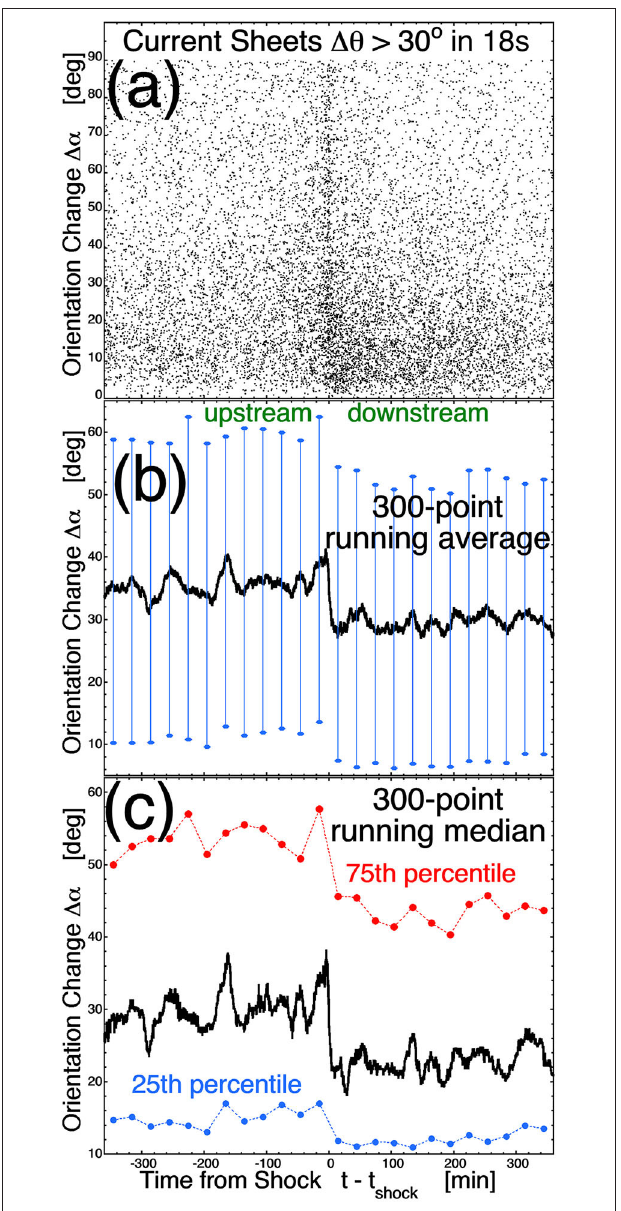
FIGURE 3 | For 11,465 current sheets from the 109 interplanetary shocks, (a) the angle 1α between one current-sheet normal and the next current-sheet normal is plotted as a function of the time at which the sheet is seen by WIND relative to the shock-crossing time. (b) A 300-point running average of the 11,465 1α values is plotted (black), ± one standard deviation (blue). (c) A 300-point running median (red) of the 11,465 1α values, the 75th percentile (red) and the 25th percentile